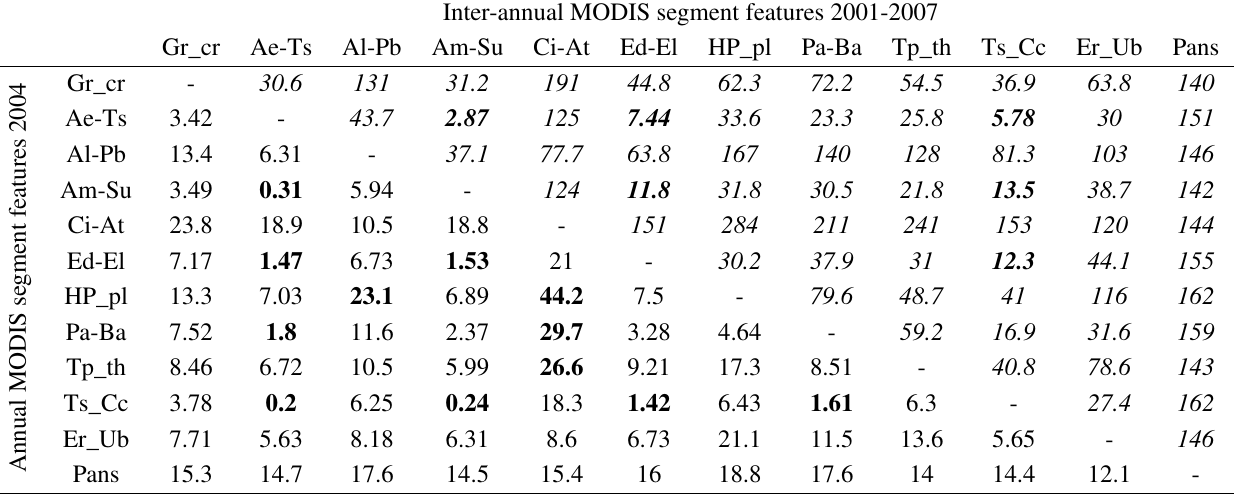
Table 2. Matrix showing average Bhattacharyya distance measures between Kalahari vegetation type classes calculated on MODIS intra-annual segment metrics for the season 2003–2004 (lower left) versus long-term inter-annual MODIS segment features (upper right, italic values) from 2001 to 2007. See Table 1 for detailed class labels. Note the bold values benchmarking examples for the lowest and highest B-distance